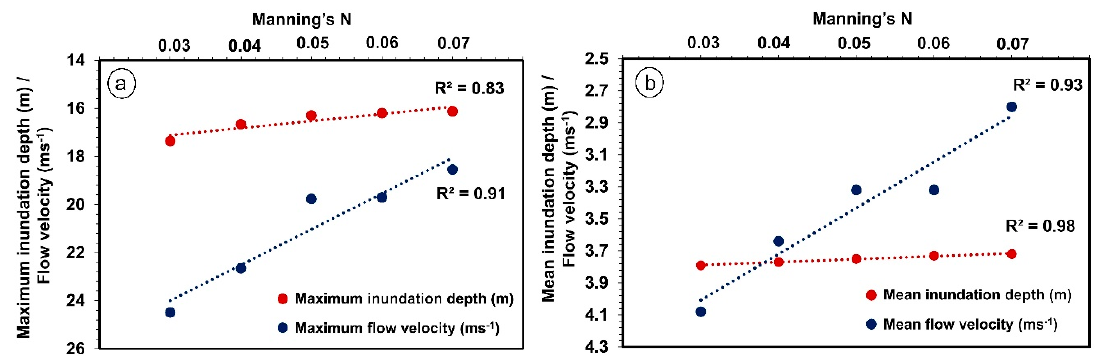
Figure 9. Plot of ( a ) Maximum inundation depth / flow velocity versus Manning’s N; ( b ) mean inundation depth / flow velocity versus Manning’s N.